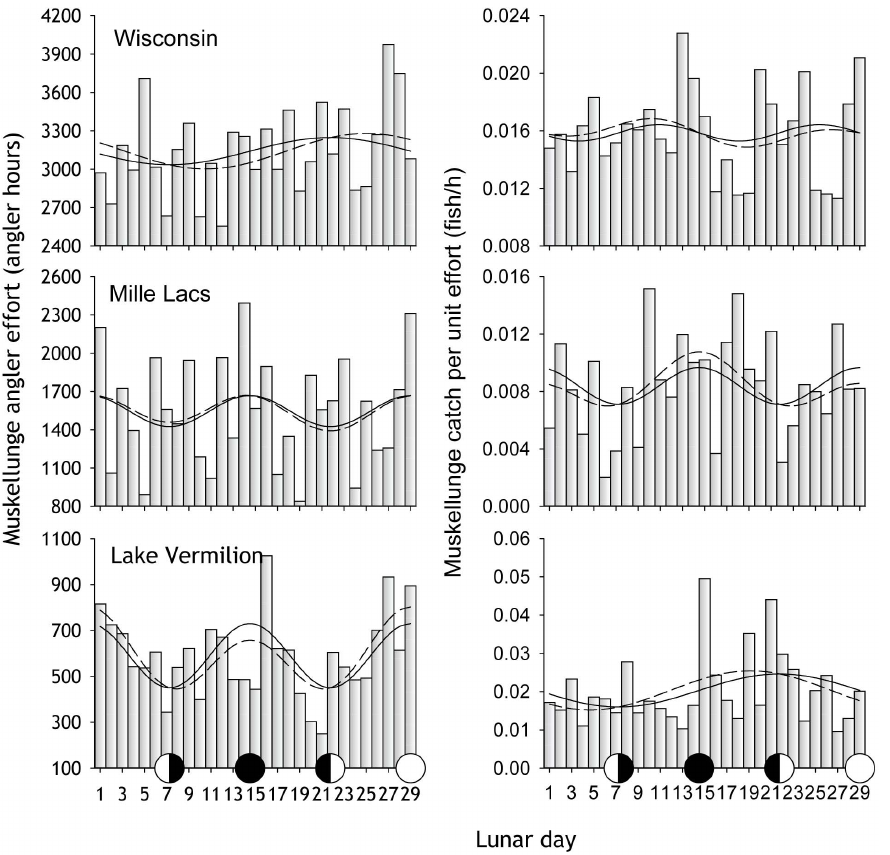
Figure 4. Periodic regression results for muskellunge fishing effort from creel surveys. Bars are Solid regression lines are for the best single-predictor model. Dashed regression lines are for the best two-predictor model. Regression statistics given in Table 1.